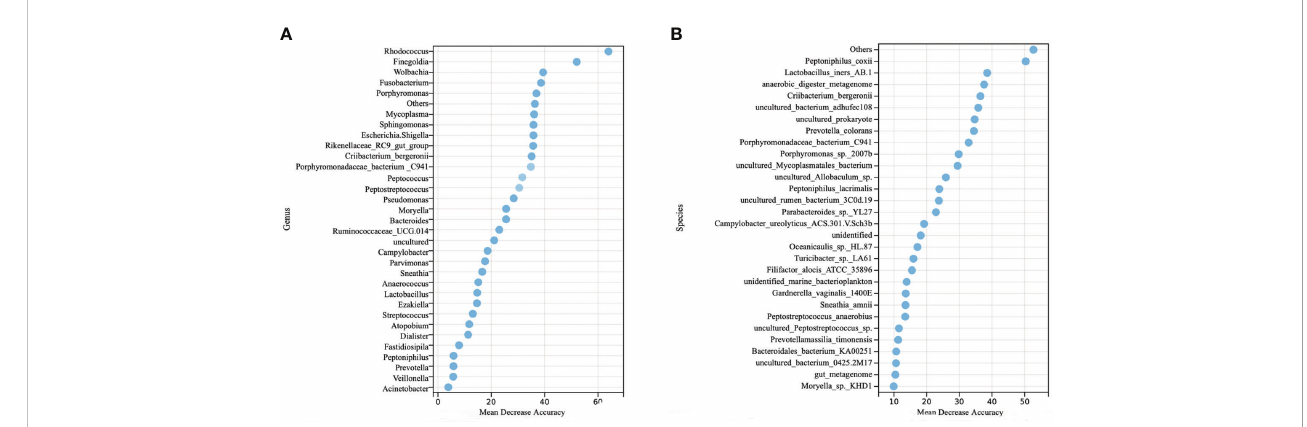
FIGURE 3 Identi fi cation of microbial genus- and species- based signatures of cervical cancer. (A) Thirty-three genera were selected as the optimal signatures panel by random forest models between 51 cervical cancer and 120 controls via a ten-fold cross-validation. (B) The top 30 optimal species signatures panel were